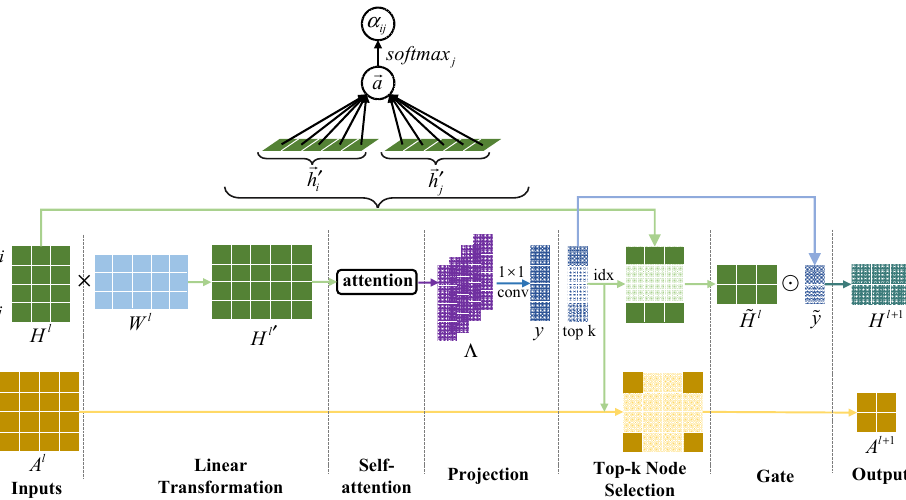
Figure 2. Overview of the proposed attention-based graph pooling layer with k = 2. We take a graph G ( A l , H l ) with adjacency matrix A l ∈ R 4 × 4 and feature matrix H l ∈ R 4 × 3 as input to form a smaller subgraph G ( A l + 1 , H l + 1 ) with A l ∈ R 2 × 2 and H l ∈ R 2 × 3 . In the linear transformation stage, we use a learnable weight matrix W l to increase the dimension of features and obtain hidden features H l (cid:48) ∈ R 4 × 5 . Then, a shared attentional mechanism is performed to compute attention coefficients. Note that a single-head attention is applied here. Λ ∈ R 4 × 4 × 1 are the column blocks from → → h (cid:48) i (cid:107) h (cid:48) j concatenated by node i , j on the coefficient matrix. The scalar α ij is the projection of the vector → a . We use a 1 × 1 conv to fuse the attention coefficients in node-level and the trainable weight vector obtain attention score y . Two nodes in A l and H l , respectively, with the highest scores are selected in the top-k node selection stage. At the gate stage, we perform element-wise multiplication between (cid:101) H l and the selected node scores vector (cid:101) y , resulting in H l + 1